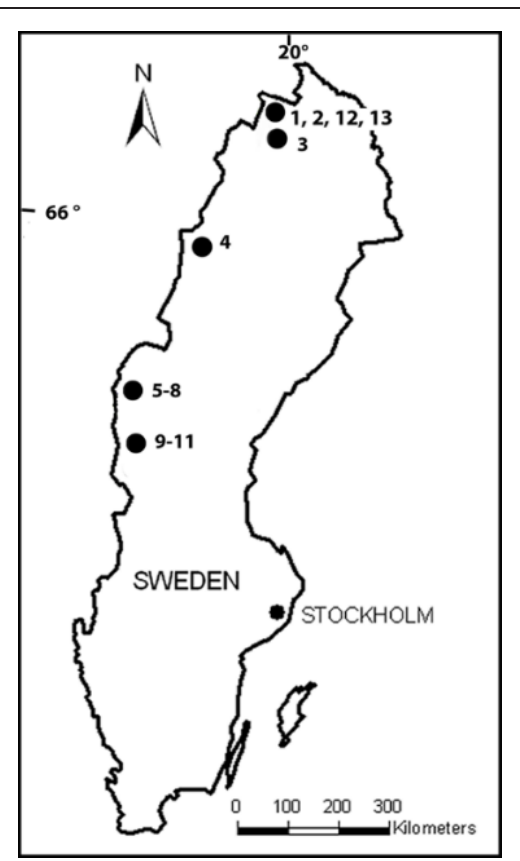
Figure 2: Present and past pine treeline of Mt. Djupgravstöten (province of Dalarna). A. Pine Figure 1: Location map showing the positions of the sampling sites along the Scandes in the northern half of Sweden. Numbers refer to Table 1.